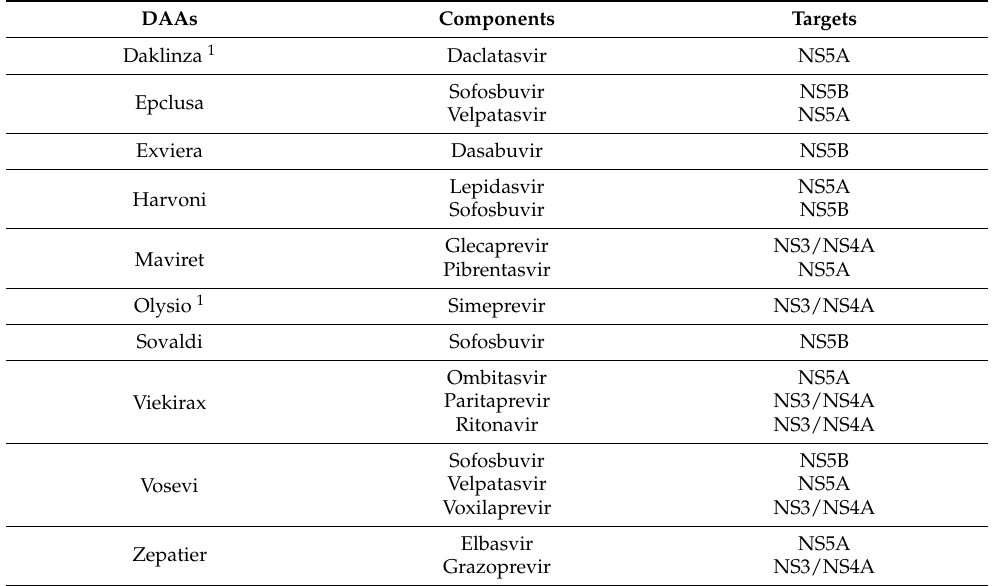
Table 1. Direct-acting antivirals approved by EMA for the treatment of chronic HCV